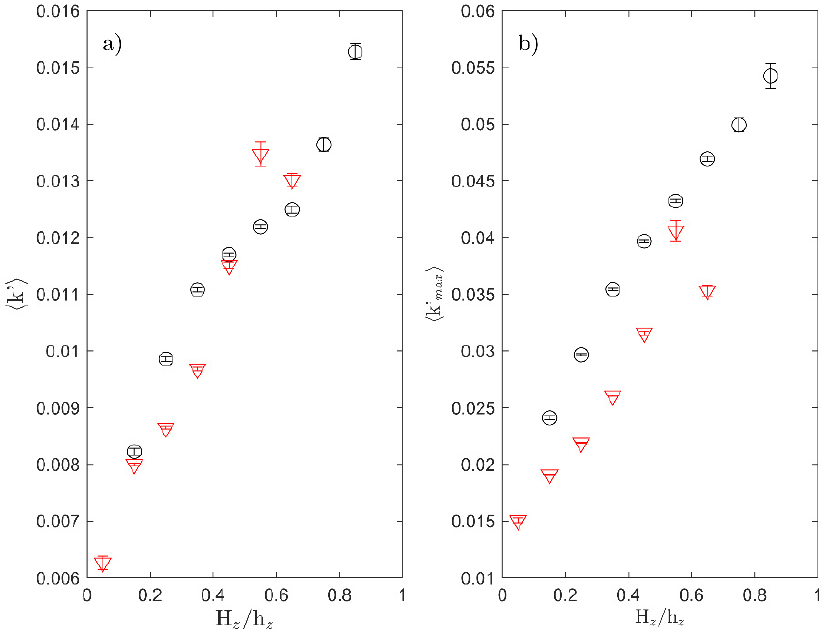
Figure 6. Near-bed ( z = 0.05–0.10 m) wave-cycle and bin-averaged < k’ > ( a ) and k’ max ( b ) plotted against relative zero-crossing wave height ( H z / h z ). Red symbols are for Vejers beach with mainly spilling breakers while black symbols represent the swell-dominated beach at Durras with mainly plunging breakers. The vertical bars show the standard error on the means within each γ -bin. From Christensen et al. [74].